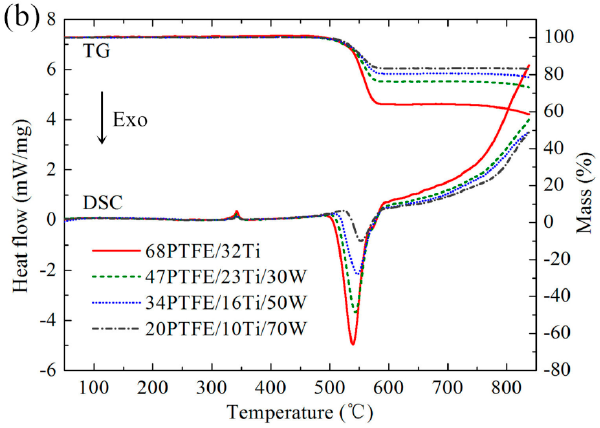
Figure 4. DSC/TG curves of ( a ) Pure PTFE and ( b ) PTFE/Ti/W composites at 5 °C/min heating rate.